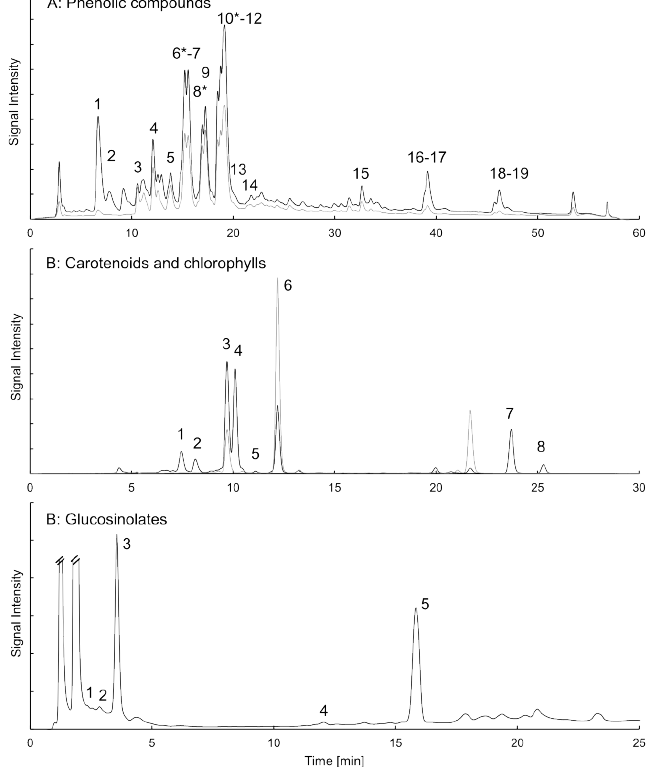
Fig. 2: Exemplary chromatograms of northern located kale ( Brassica olera- cea var. sabellica L.) samples, gathered after 6 weeks of growth. A: phenolic compounds measured at 330 nm (black line) and 370 nm (grey line); 1: neochlorogenic acid, 2 : Q-3,7,4’-triglc, 3: K-3- O - soph-7- O -glc, 4: Q-3- O -soph-7- O -glc, 5: K-3- O -hfer-soph-7- O - glc, 6: K-3- O -hfer-soph-7- O -diglc; 6*: Q-3,7-di- O -glc (shoulder peak at low concentration) 7: K-3- O -caf-soph-7- O -glc 8: Q-3- O - sin-soph-7- O -glc, 8*: K-3- O -caf-soph-7- O -diglc (shoulder peak at low concentration), 9: Q-3- O -soph-sin-7- O -diglc, 10: K-3- O -sin- soph-7- O -glc, 10 * : Q-3- O -fer-soph-7- O -glc (small shoulder peak), 11: K-3- O -sin-soph-7- O -diglc, 12: K-3- O -fer-soph-7- O -glc, 13: K-3- O -fer-soph-7- O -diglc, 14: K-3- O -cou-soph-7- O -glc, 15: I-glc, 16: Disinapoyl-gentiobiose, 17: Sinapoylferuloyl-gentiobiose, 18: Trisinapoyl-gentiobiose, 19: Disinapoylferuloyl-gentiobiose; B: Carotenoids and chlorophylls measured at 450 nm (grey line) and 660 nm (black line). Abbreviations referrer to footnotes explained in Tab. 2.; 1: Violaxanthin, 2: Neoxanthin, 3: Chlorophyll b, 4: Lutein, 5: Zeaxanthin, 6: Chlorophyll b, 7: (all- E )-β-Carotene, 8: (9Z)-β- Carotene. C: Glucosinolates measured at 259 nm: 1: Progoitin, 2: Epirogoitin, 3: Sinigrin, 4: Glucobrassicanapin, 5: Glucobrassicin.